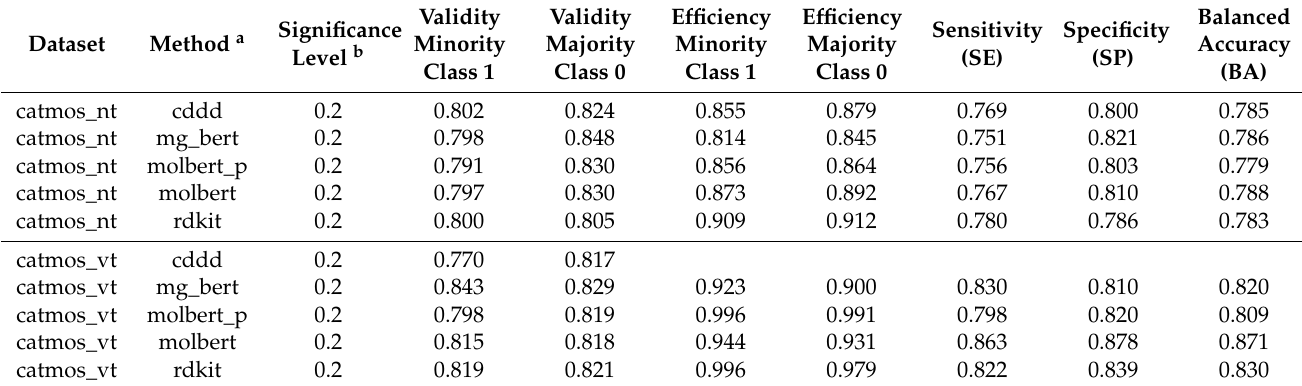
a : cddd = RF/cddd 10 models, mg_bert = Molecular-graph-BERT/smiles 10 models, molbert = Mol- BERT/smiles 10 models, molbert_p = MolBERT/smiles 10 models with PubChem pre-trained model, rdkit = RF/rdkit 10 models, b = CP significance level.